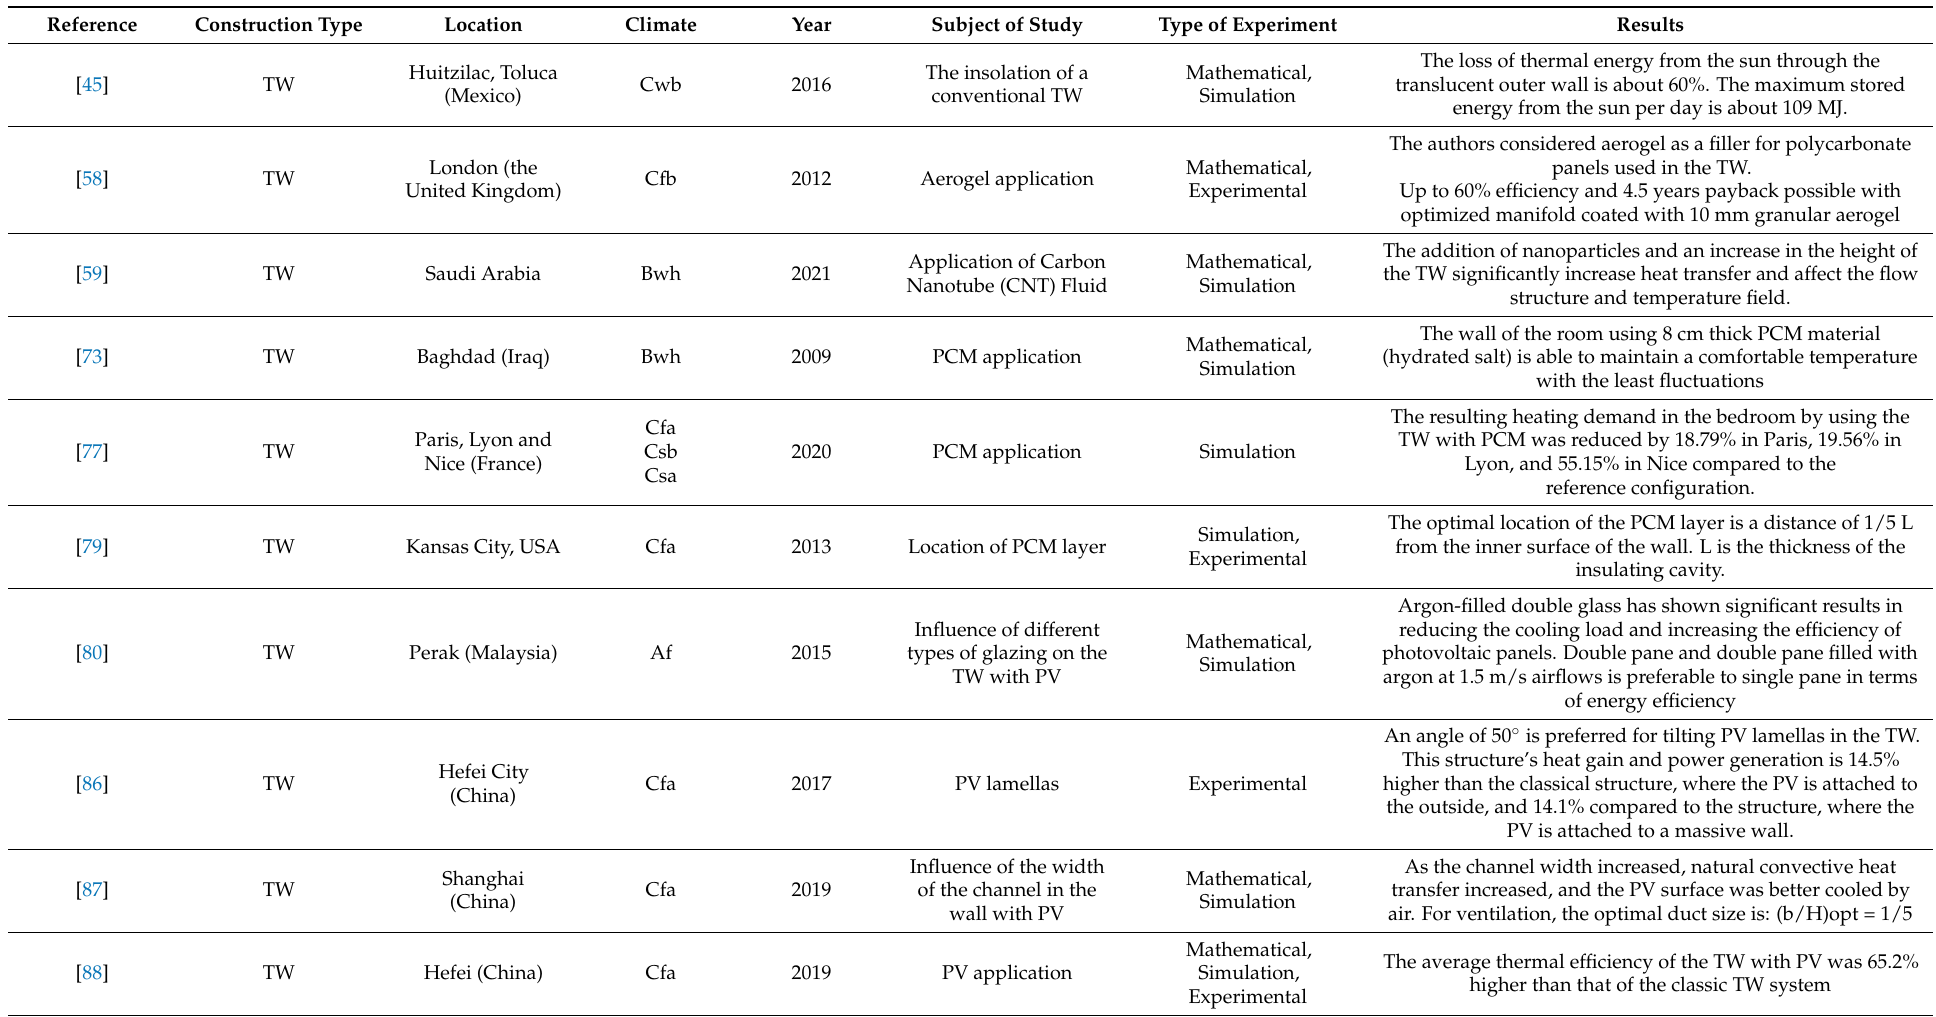
Table 5. Systematization of the obtained